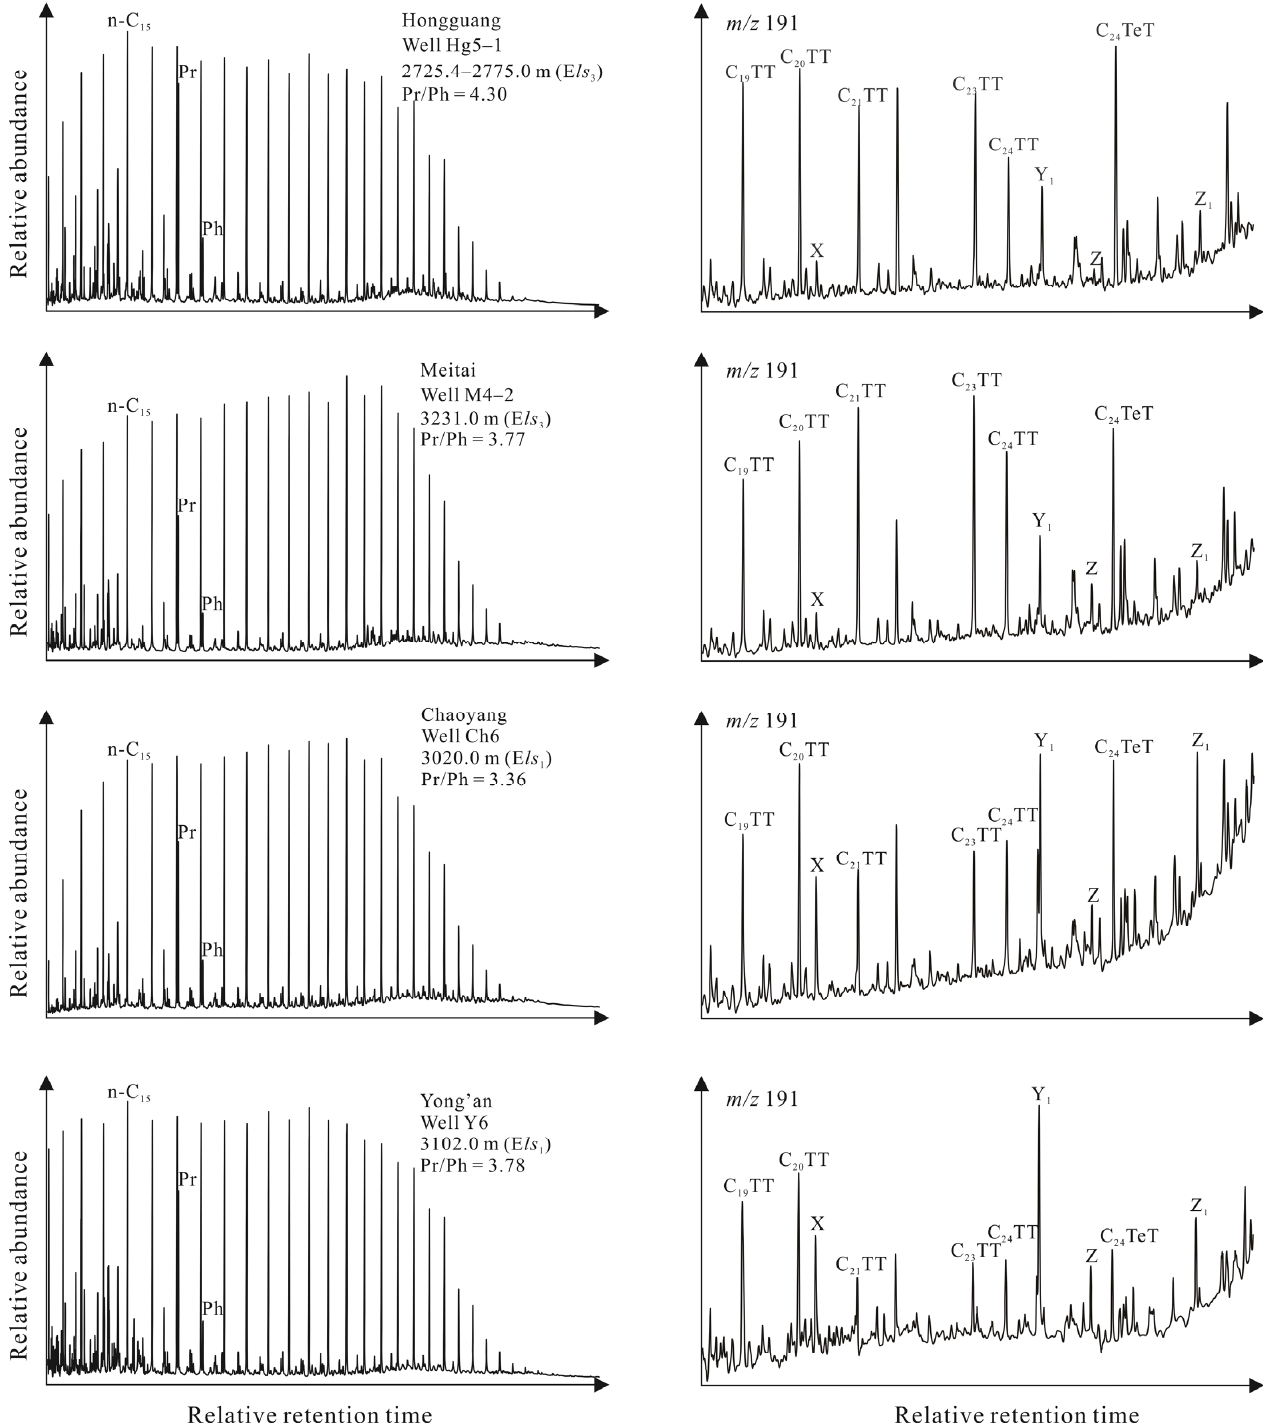
Figure 3. TIC and mass chromatograms ( m / z 191) showing the distribution of normal alkanes and tricyclic terpanes. Note: Pr = Pristane; Ph = Phytane; TT = tricyclic terpane; C 24 TeT = C 24 tetracyclic terpane; X = C 21 tricyclic terpanes; Y 1 = C 25 tricyclic terpanes; Z = C 24 -des-A-ursane; Z 1 = C 27 tetracyclic terpane.